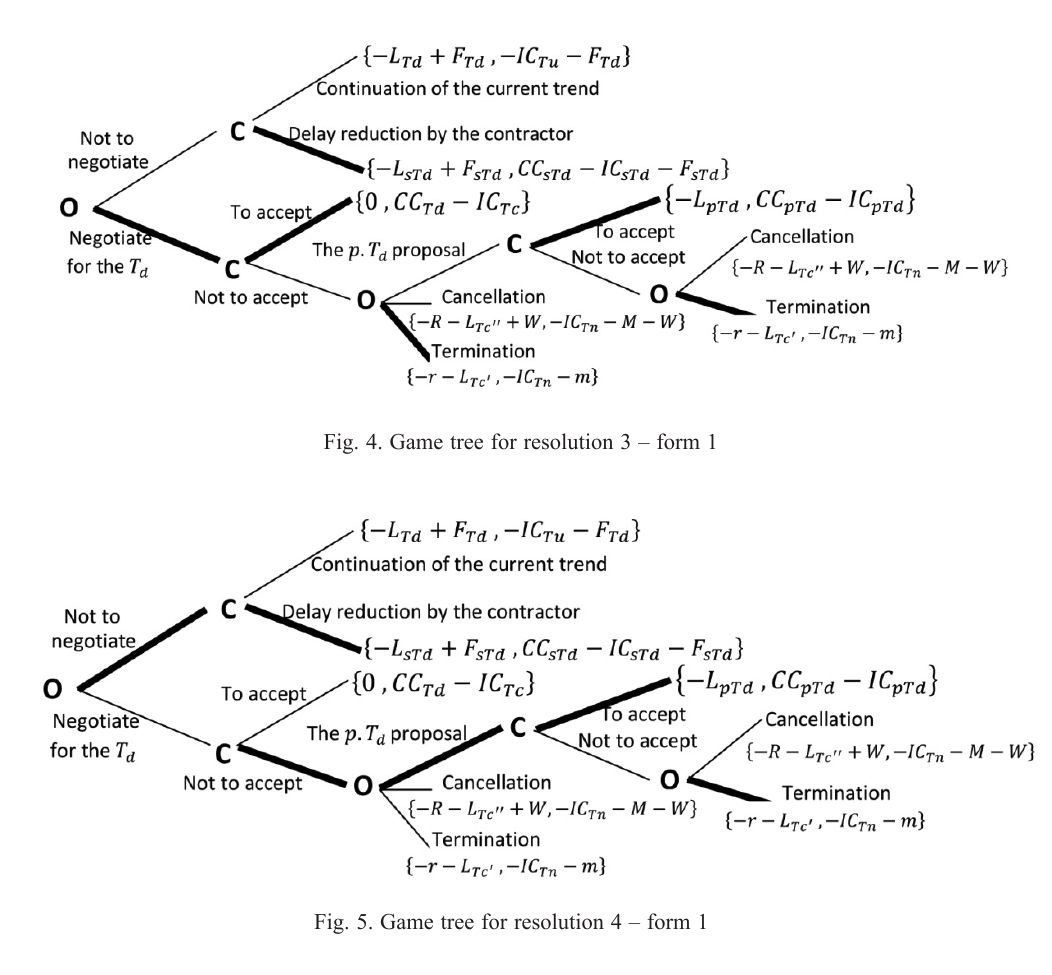
Fig. 5. Game tree for resolution 4 – form